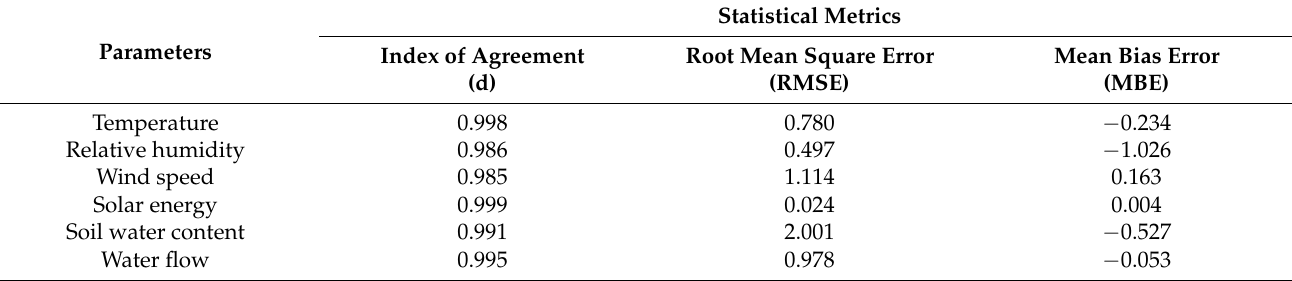
Table 2. Statistical metrics values resulting from comparing the measured values of the temperature & relative humidity sensor, solar energy sensor, wind speed sensor, volumetric water content sensor, and water flow sensor with the observed values of the required weather, soil, water parameters of temperature ( ◦ C), relative humidity (%), wind speed (m h − 1 ),